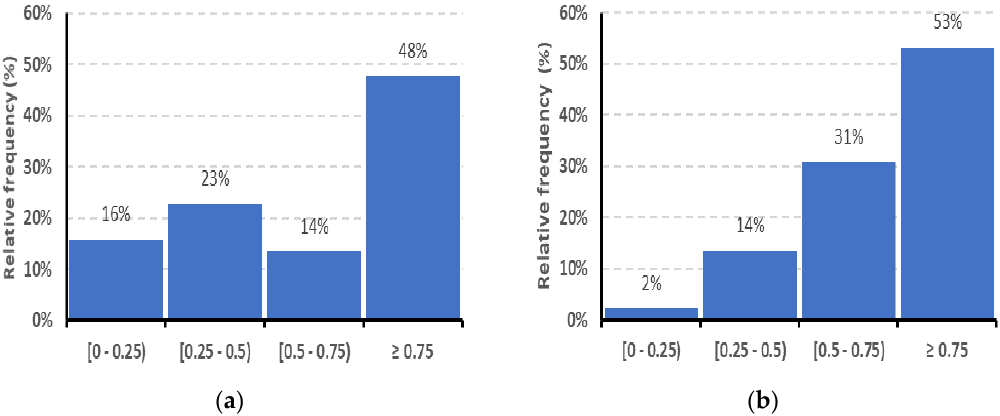
Figure 4. Histograms of the distribution of the R 2 estimator for ( a ) 3rd degree polynomial adjustment and ( b ) 4th degree polynomial adjustment.